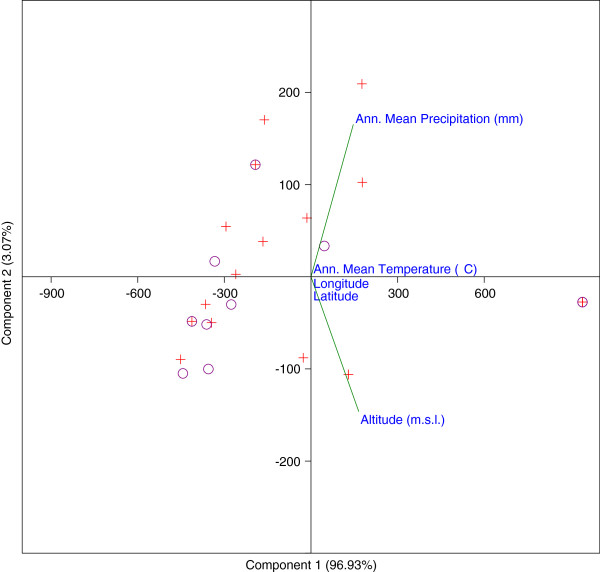
PCA-biplot score of the accessions of Solanum galapagense (violet circle symbol) and S. cheesmaniae (red plus sign symbol) based on geographic/climatic variables.